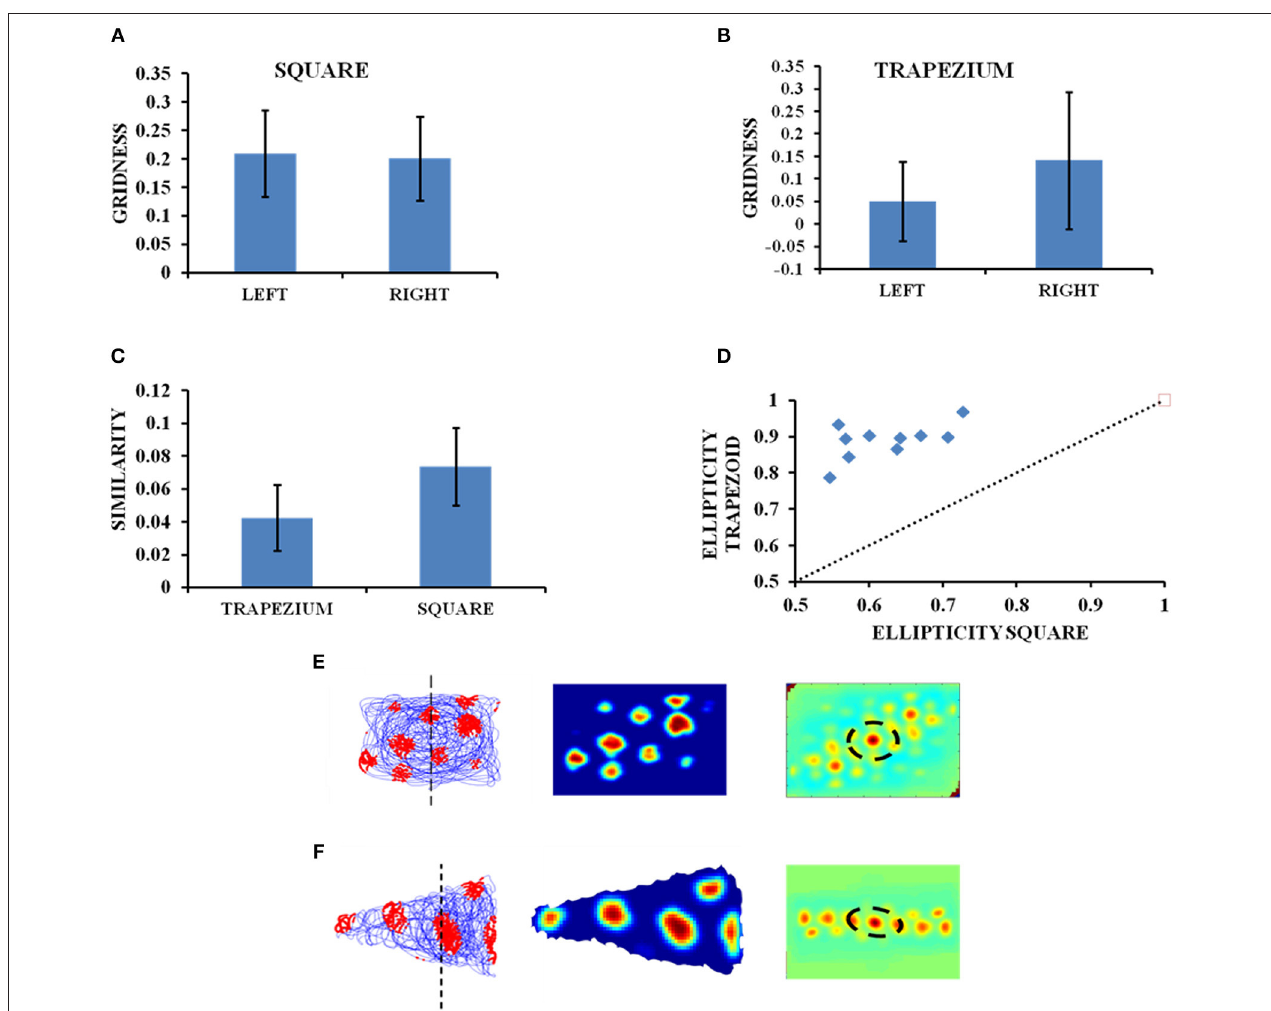
FIGURE 4 | Grid cell firing in square and trapezoid enclosures. (A,B) Average HGS values plotted for the left and right orientation of the square and trapezium boundaries. (C) Model results—Right and left sides of square are more similar than that of a trapezium. (D) Model results—Ellipticity between a square and a trapezoid. (E,F) Firing field, firing rate, and autocorrelation maps of the square and trapezoid boundaries, respectively.